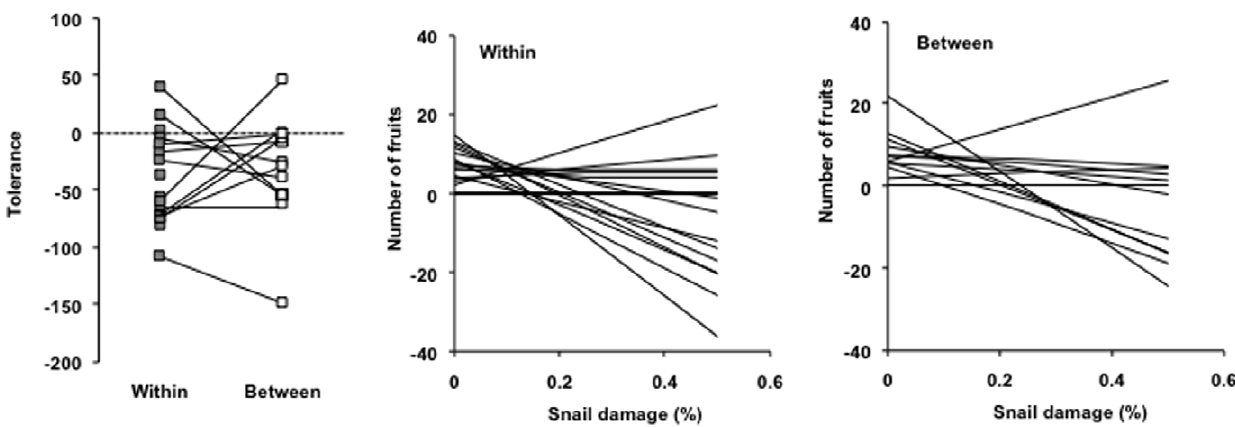
Figure 2. Among-population variation in outbreeding effects on tolerance and plant fitness. Among-population variation in a) outbreeding effects on tolerance and in the effects of snail damage on the number of fruits produced for b) plants from within-population and c) between-population crosses in the snail herbivory experiment. Tolerance is assessed as slope of fitness (number of fruits) and leaf damage %. Thus, tolerance is given in units of change in the number of fruits per % leaf area damaged. The squares in a) denote slopes for plants from within- (grey symbols) and between-population (white symbols) crosses for each population. The lines illustrate differences in tolerance between plants within-and between population crosses for each population. Tolerance . 0 indicates overcompensation, tolerance =0 full compensation, and tolerance , 0 undercompensation. In figures b) and c) each line represents a population.